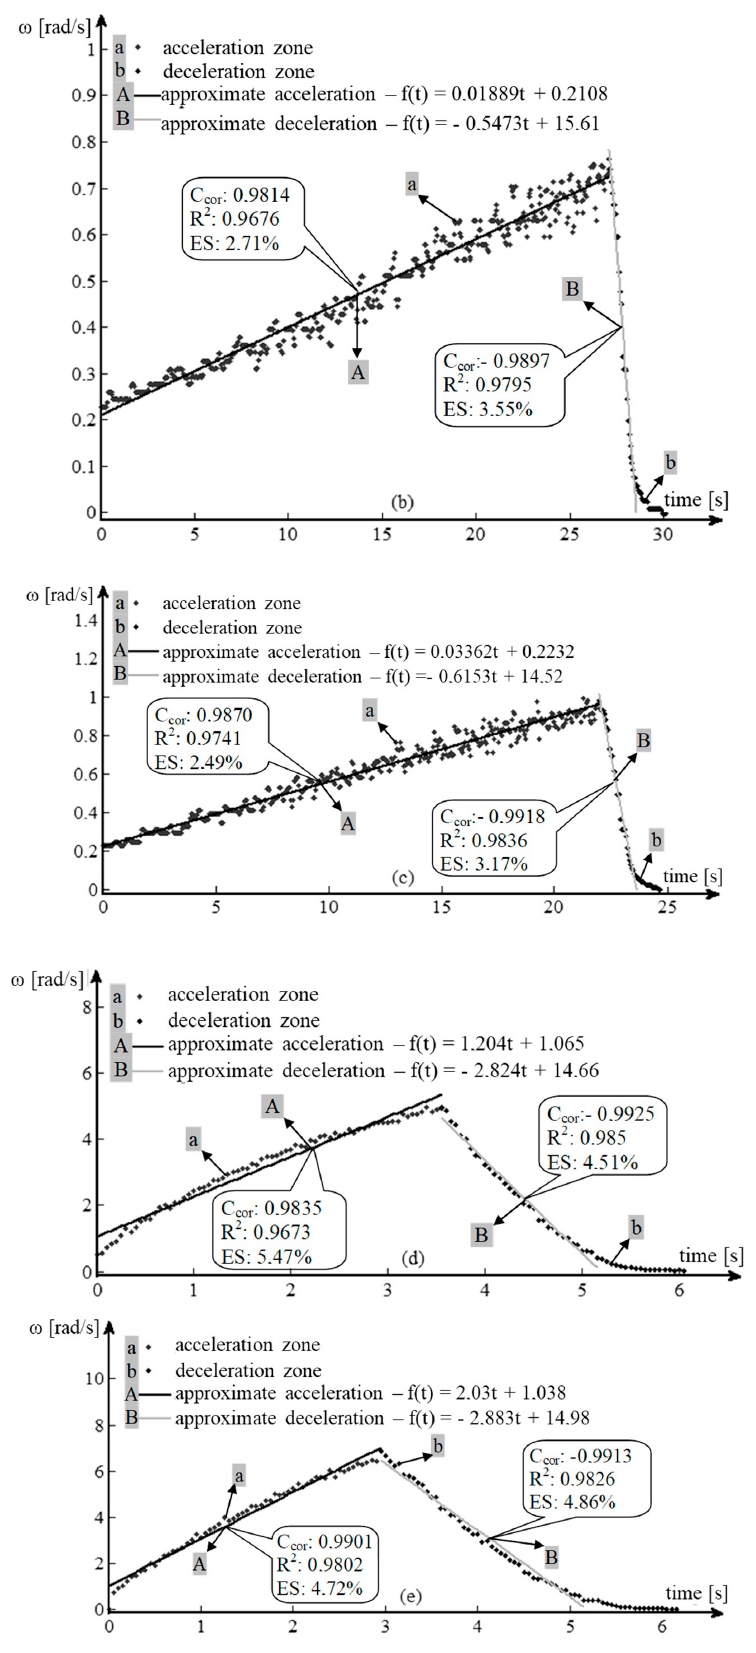
Figure 21. Experimental data processing. Modeling accuracy parameters. ( a ) I gear, probe 3; ( b ) II gear, probe 1; ( c ) III gear, probe 1; ( d ) IV gear, probe 3; ( e ) neutral, probe 1. The value of the coefficient of determination (24) is close to the unit value for all samples, which means that a high percentage of the experimental data are very close to the calculated values, as follows: